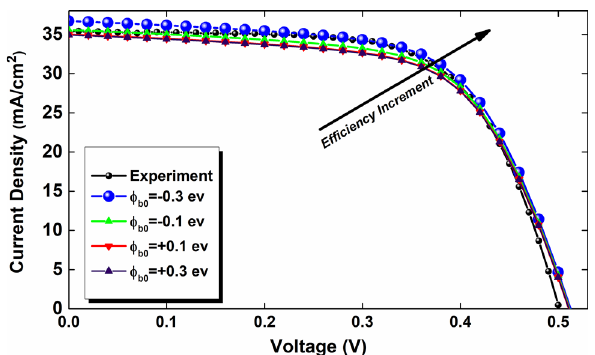
Figure 3. Current density versus voltage curves of the cell by optimization the potential barrier effect in front